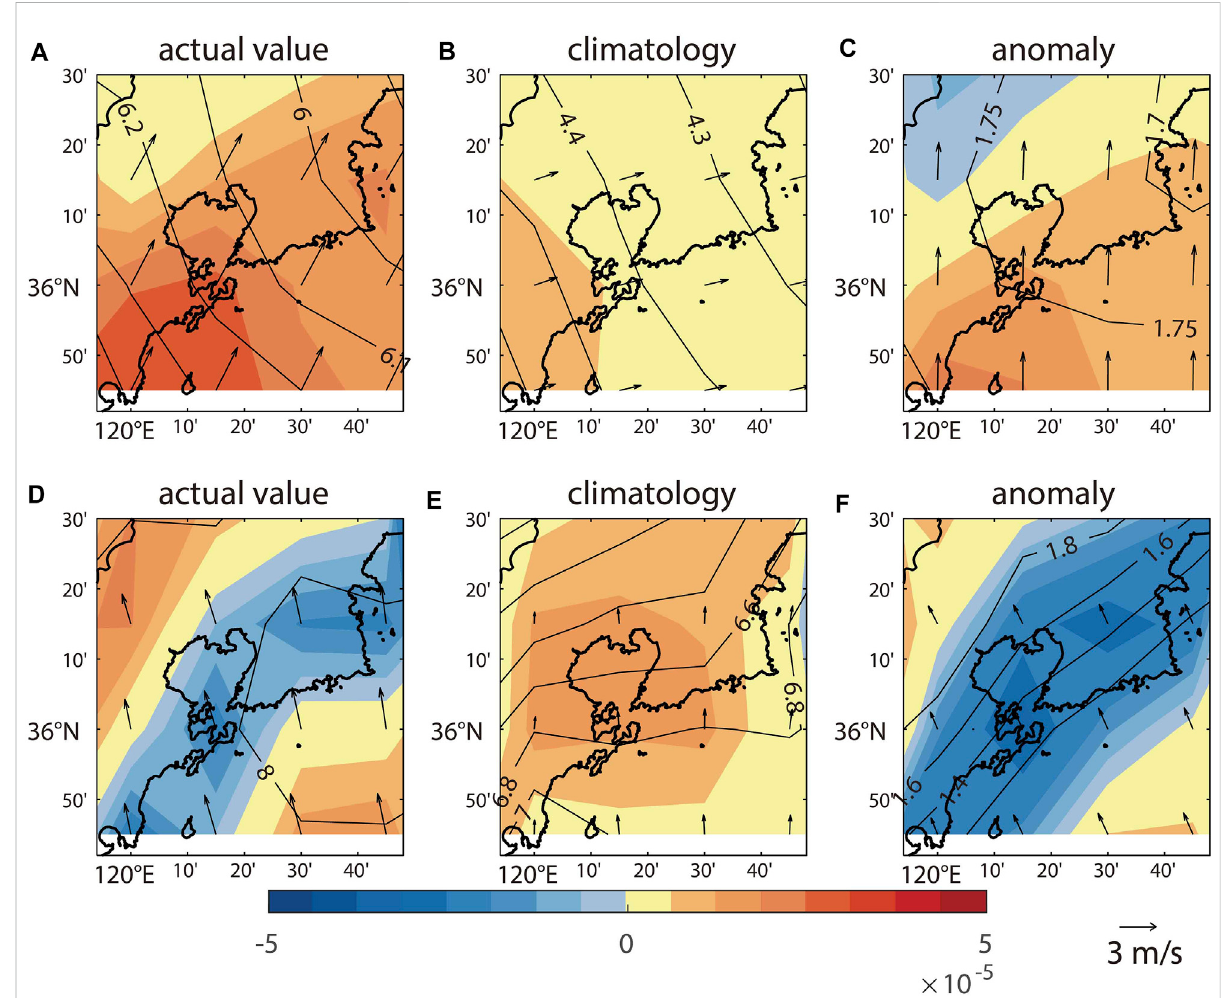
FIGURE 7 Composite results of time-averaged moisture advection (g/kg · s; shading) during day 0 00 – 23 LST at 925 hPa (top) and at the surface (bottom) for all SFP events based on ERA5. Left, middle, and right panels are actual, climatological, and anomalous values, respectively. The advection is given by shading, and speci fi c humidity (g/kg) by contours. The arrows represent